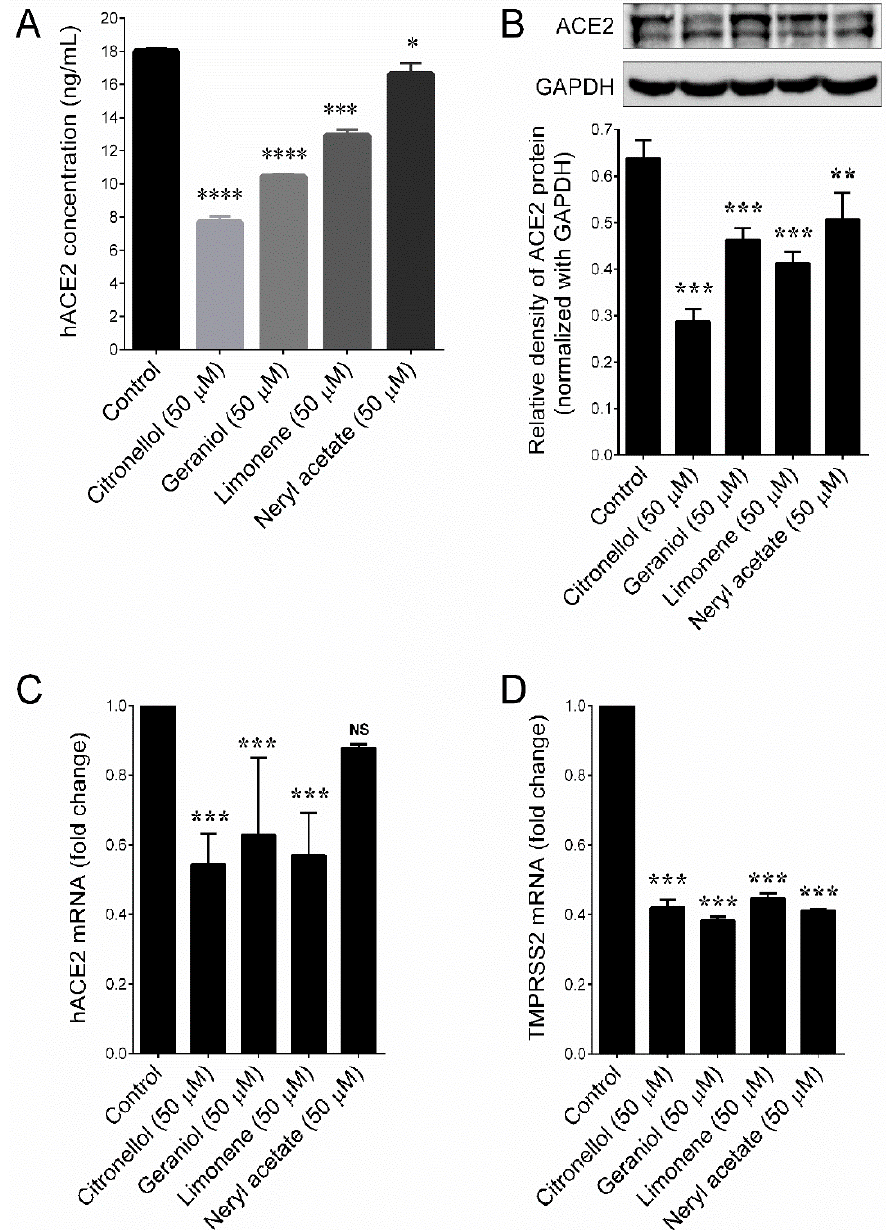
Figure 4. ACE2 inhibitory e ff ects of major compounds of geranium and lemon essential oils. ( A ) ACE2 activity in HT-29 cells were determined by ELISA assay. ( B ) Protein expression levels of ACE2 were determined by immunoblotting. Relative density of one representative experiment is shown, where ACE2 signal was normalized to GAPDH signal. ( C , D ) Relative expression of ACE2 and TMPRSS2 mRNAs in HT-29 cells. Values represent the mean ± SD of three independent experiments. p -values of less than 0.05 *, 0.01 **, 0.001 ***, and 0.0001 **** were considered statistically significant for the sample treatment group vs. the control group.